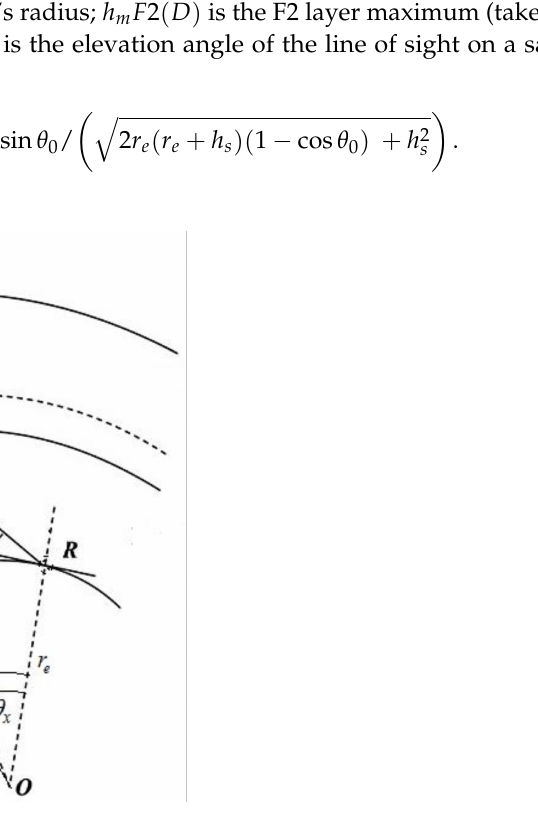
Figure 6. Diagram for determining the localization point of the F2 layer critical frequency